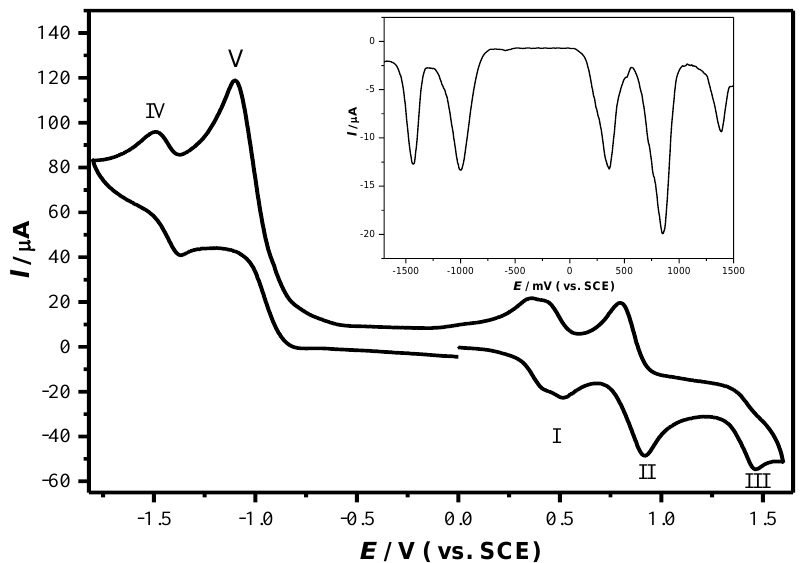
Figure 1. Diagram of the HOMO and LUMO of compound 1 .